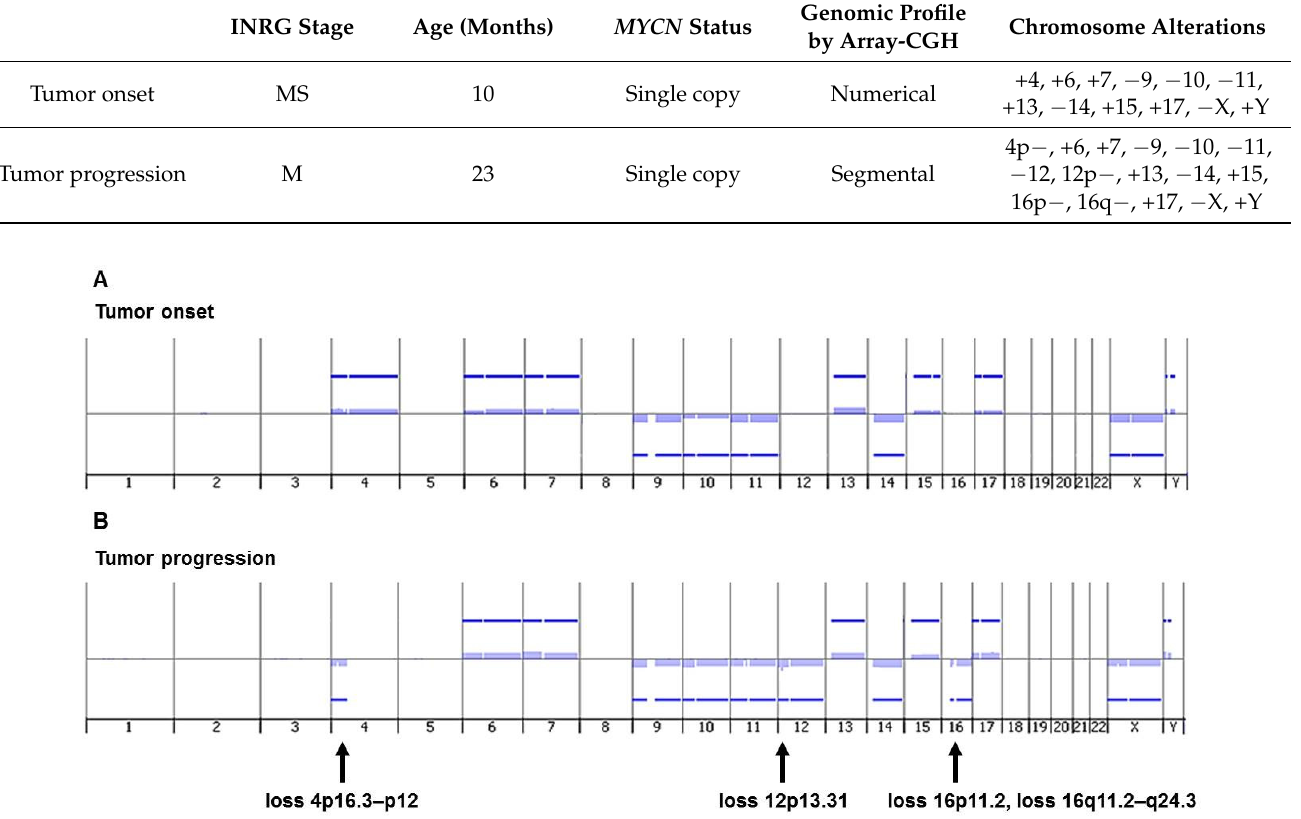
Figure 1. Genomic findings obtained by array-CGH. ( A ) Genomic profile of DNA from tumor